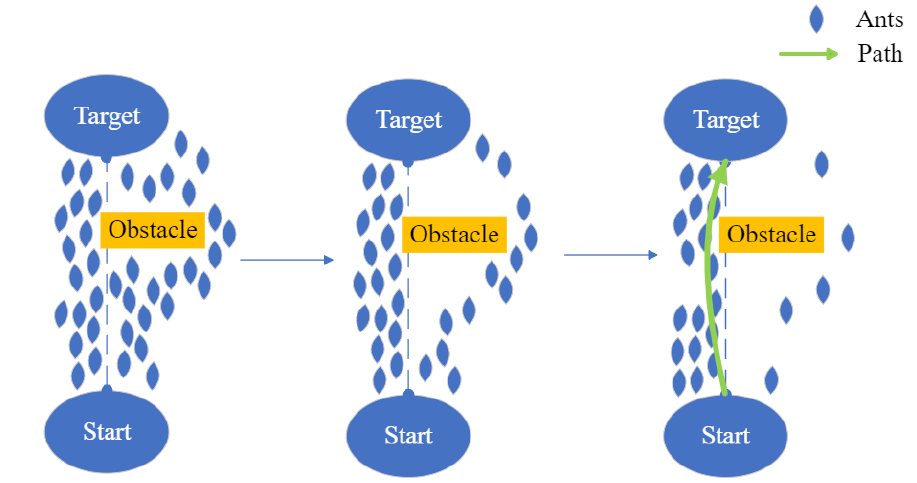
Figure 8. Changes of the ACO algorithm with different